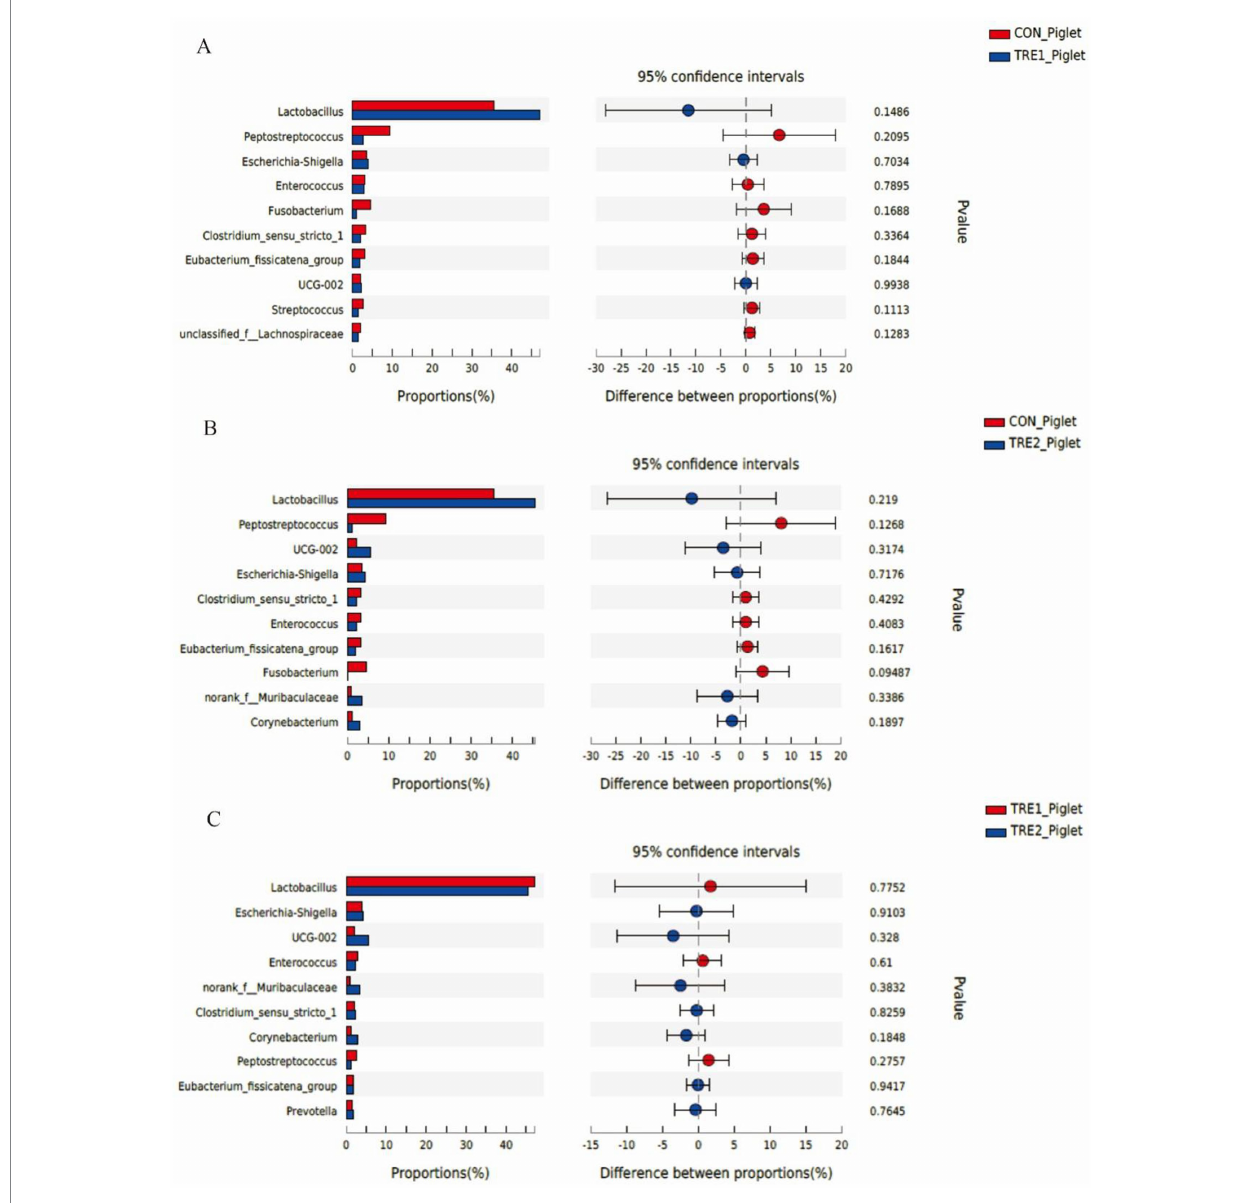
FIGURE 8 Differences in fecal microbiota of piglets at genus level among different groups. (A) The difference in fecal microbiota for piglets between the control group and TRE1 group. (B) The difference in fecal microbiota for piglets between the control group and TRE2 group. (C) The difference in fecal microbiota for piglets between TRE1 and TRE2 groups. Piglets are regarded as the experimental units, N = 5 for each